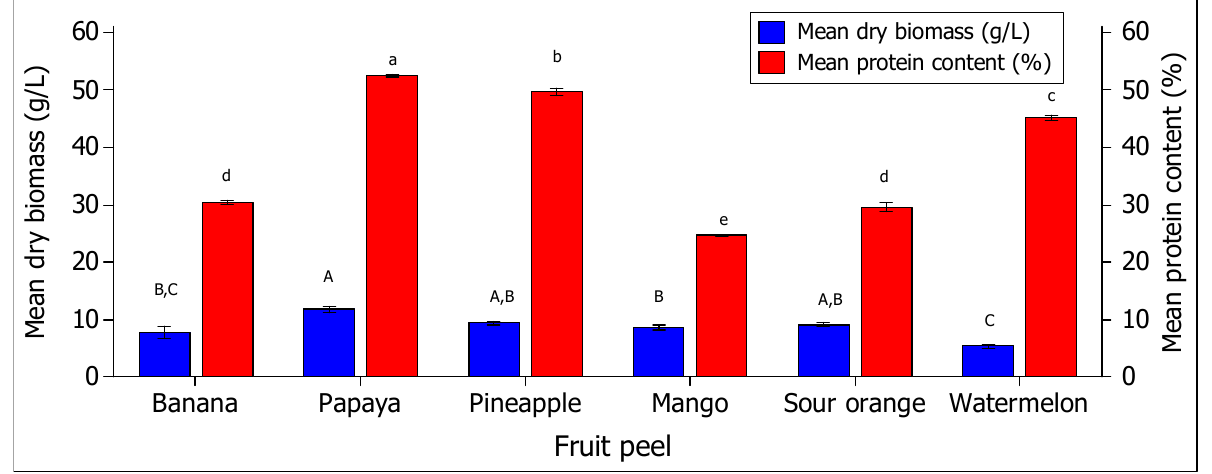
Figure 1. Effect of pineapple, watermelon, papaya, mango, sour orange, and banana peel on dry biomass and protein content of SCP produced from mixed culture of palmyrah toddy. Comparisons of mean were performed with Tukey’s multiple comparison test at p < 0.05. Different uppercase and lowercase letters indicate the significant differences in dry biomass and protein content, respec- tively.